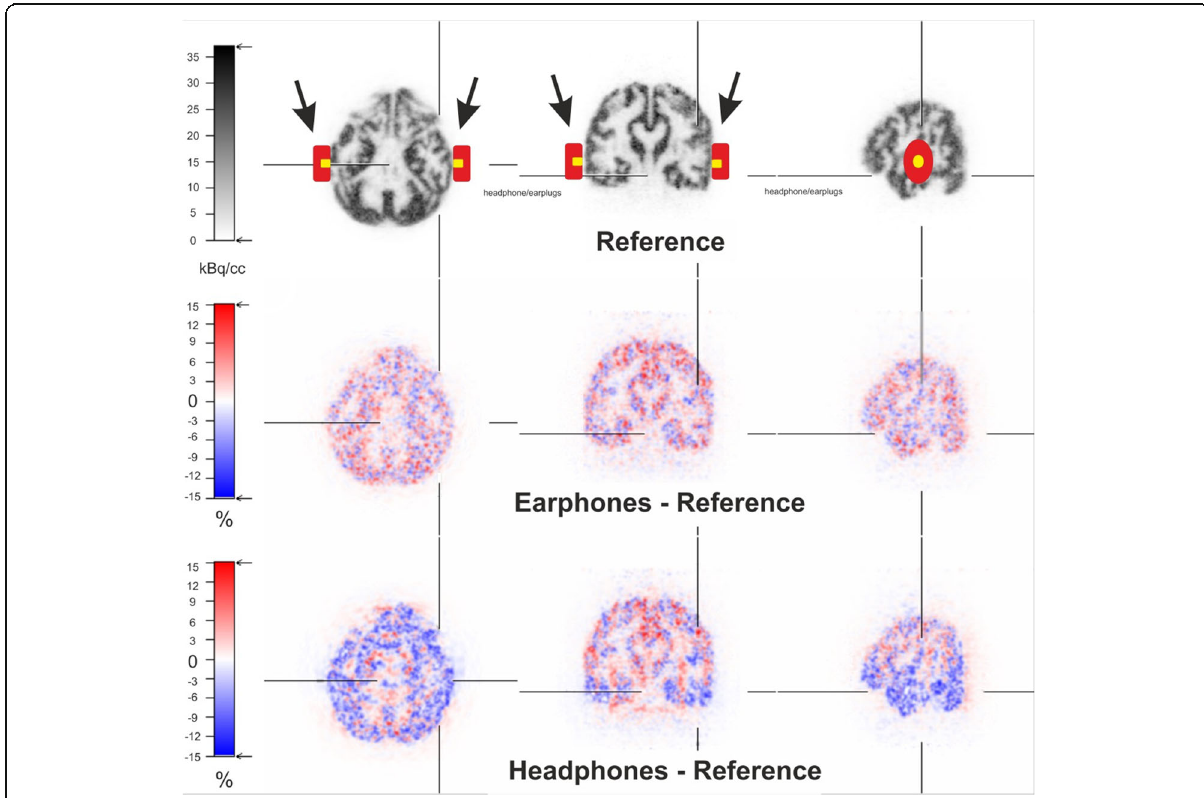
Fig. 4 Emission image of the Iida phantom without headphones/earphones combined with the schematic drawing indicating the position of the phones if applied (above). Difference image between earphones and reference (middle) and between headphones and reference (below),